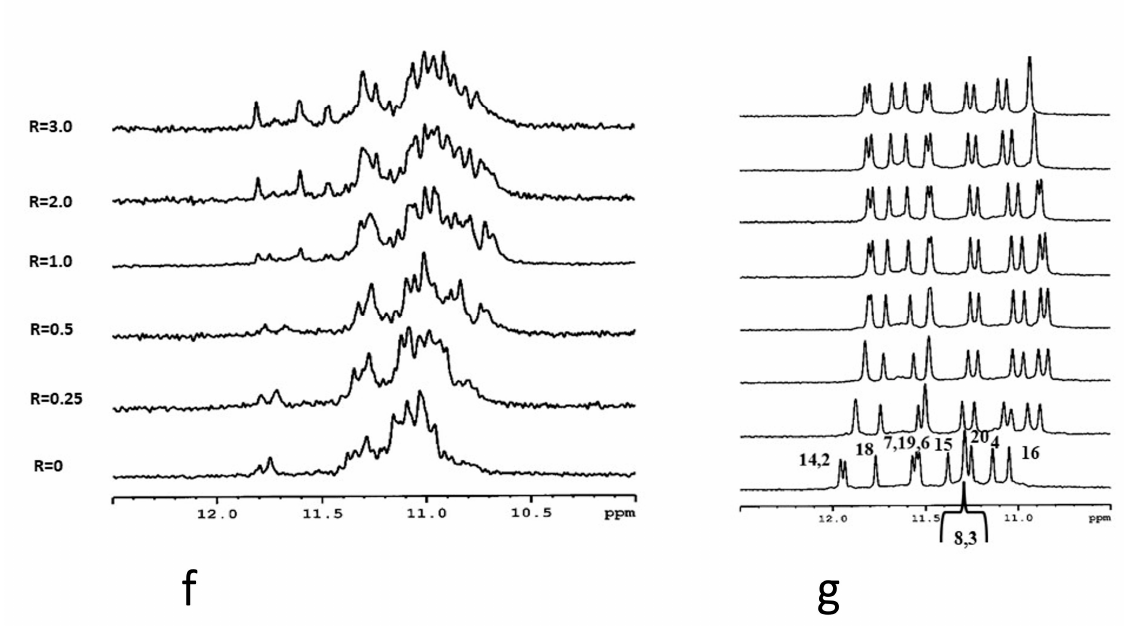
Figure 5. Imino proton region of the 1D NMR titration spectra of nmyc01 ( a ), nmyc01m ( b ), and 22nt ( c ) at 25 °C and at different R = [drug]/[DNA] ratios. Imino protons ( d ) and aromatic protons ( e ) regions of the 1D NMR titration spectra of DL40 at 25 °C and different R = (drug)/(DNA) ratios. Imino protons region of the 1D NMR titration spectra of GG1 ( f ) and ckit21T12T21 ( g ) at 25 °C and different R = (drug)/(DNA) ratios.